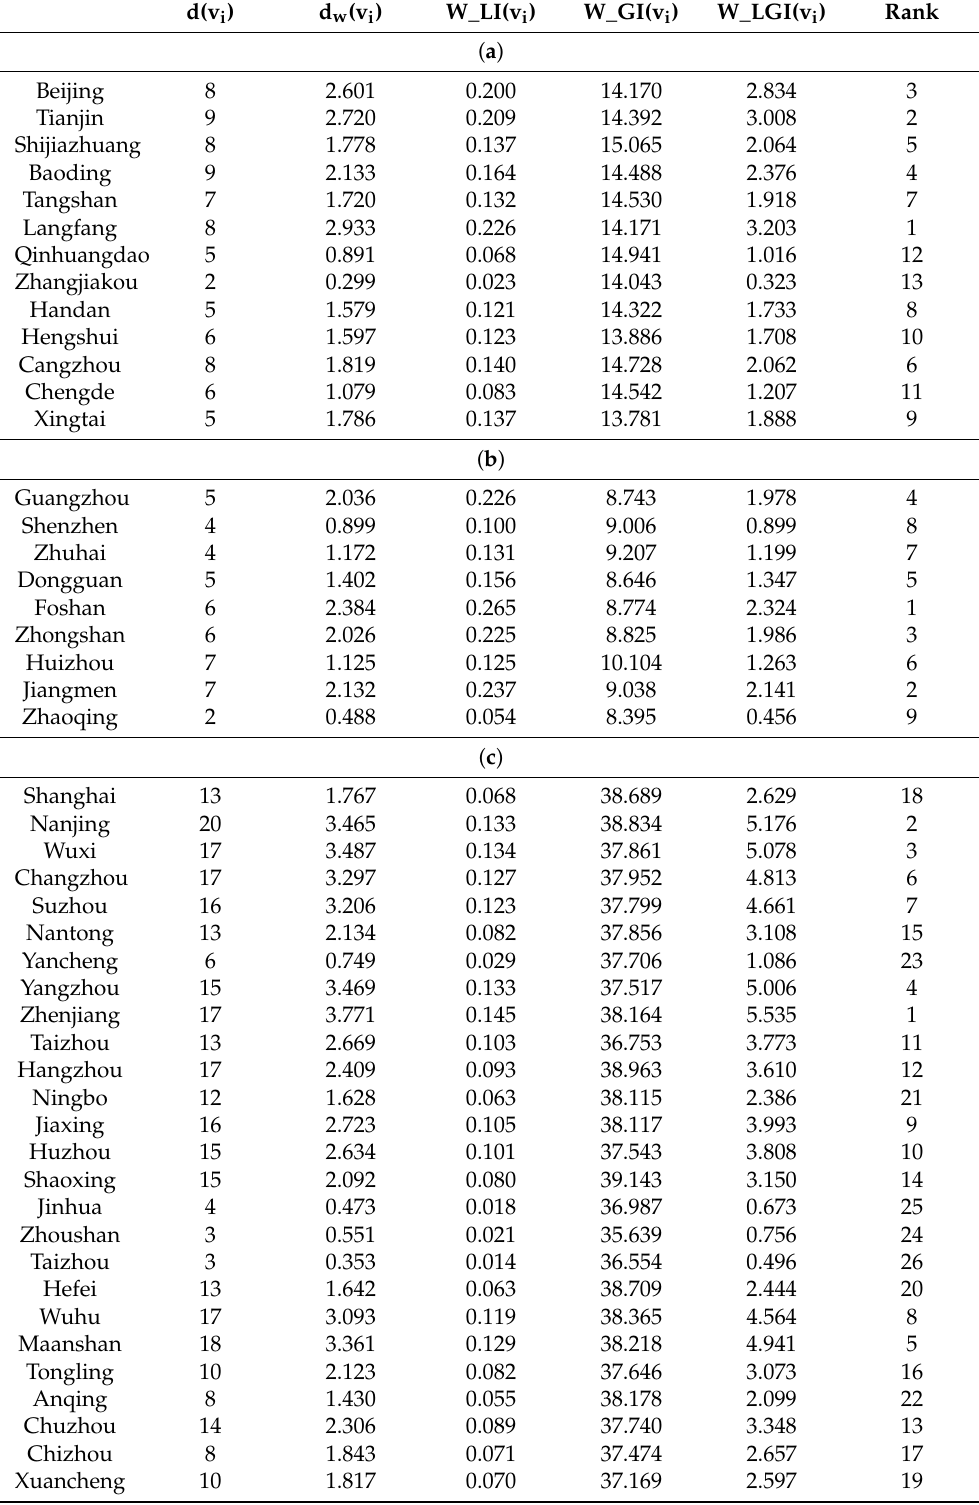
Table 2. The attribute values of each node in the three major urban agglomeration